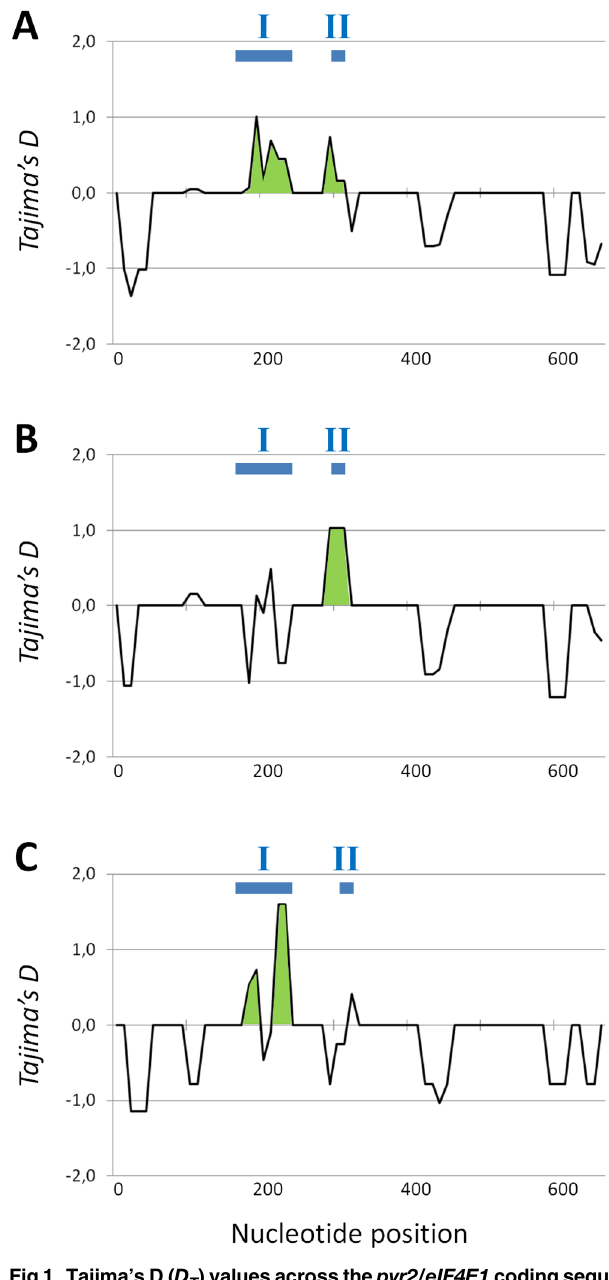
Fig 1. Tajima ’ s D ( D T ) values across the pvr2/eIF4E1 coding sequences of all (A), wild (B) and cultivated (C) chiltepin populations. The green areas indicate the maximum of D T values. I and II delimit the protein regions I and II involved in potyvirus resistance (as described in